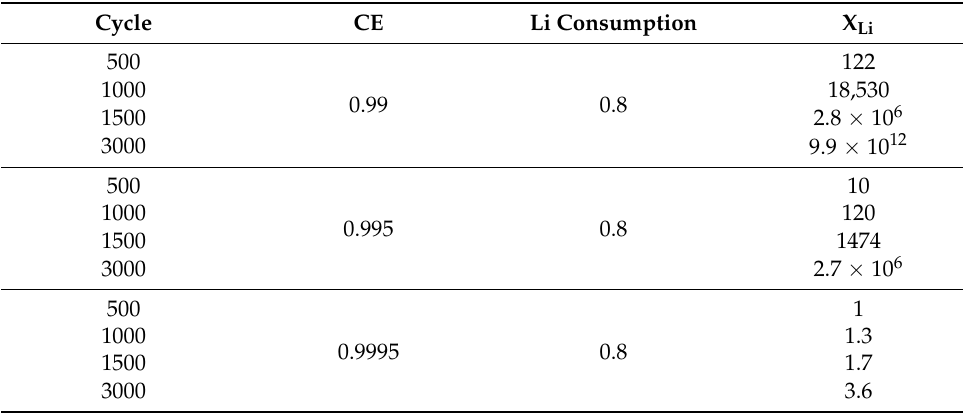
Table 5. Need of CE and excess lithium for different cycle